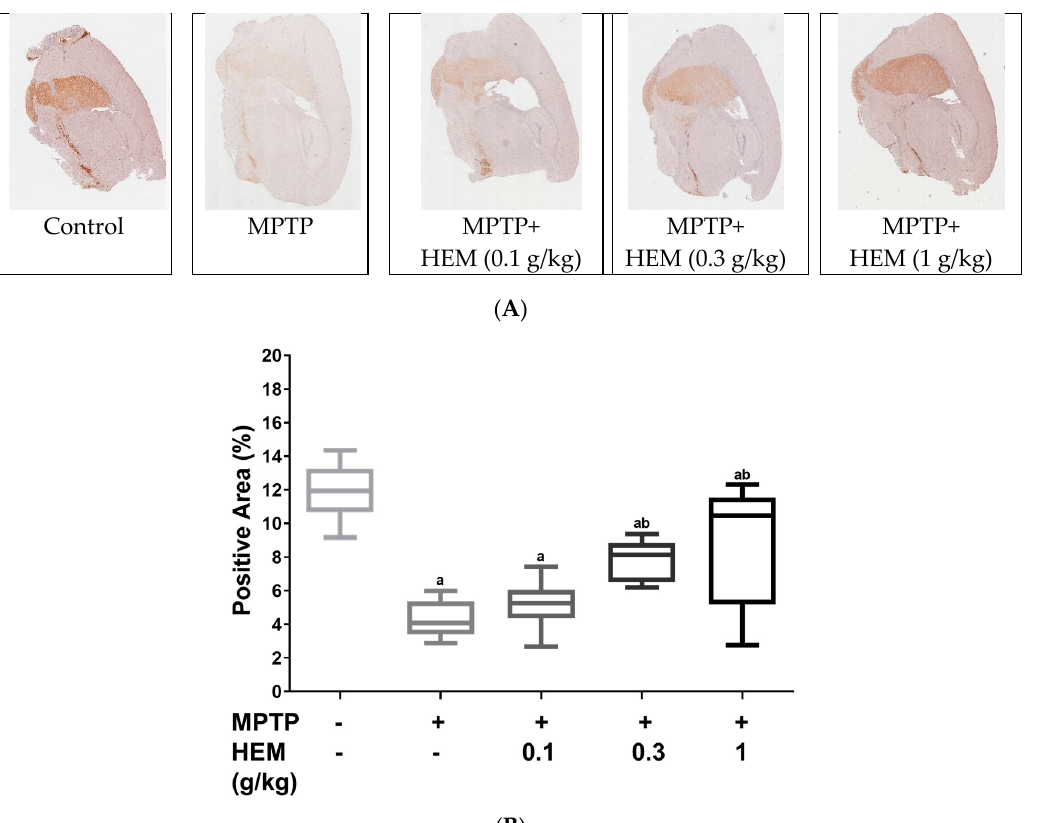
Figure 5. ( A ) Immunohistochemical staining of tyrosine hydroxylase (TH). The MPTP group exhibited dopamine deficiency syndrome. Co-treatment of HEM ameliorated MPTP-reduced TH expression in a dose-dependent manner. ( B ) The positive area of striatum is expressed in a Box and Whisker Plot. The results reflect the mean values of cells. The letter “a” represents a statistical difference ( p < 0.01) compared to the control group, while the letter “b” represents a statistical difference ( p < 0.01) compared to the MPTP treatment group. The statistical analysis was performed using Holm-Sidak tests.